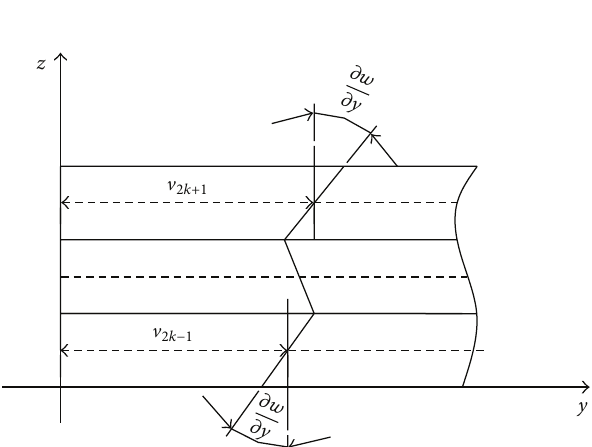
Figure 2: The deformation of 𝑥 .